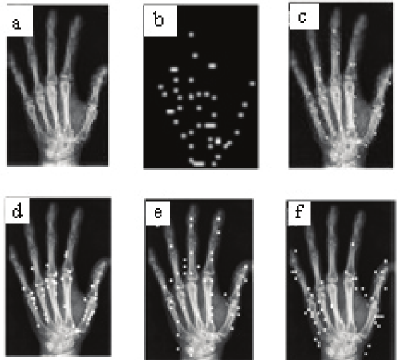
Figure 7: (a) X-ray Image (b) Proposed method (c) Superimposed image (d) Kadir’s method[20] (e ) Itti’s method[19] (f) Liu’s method [25]